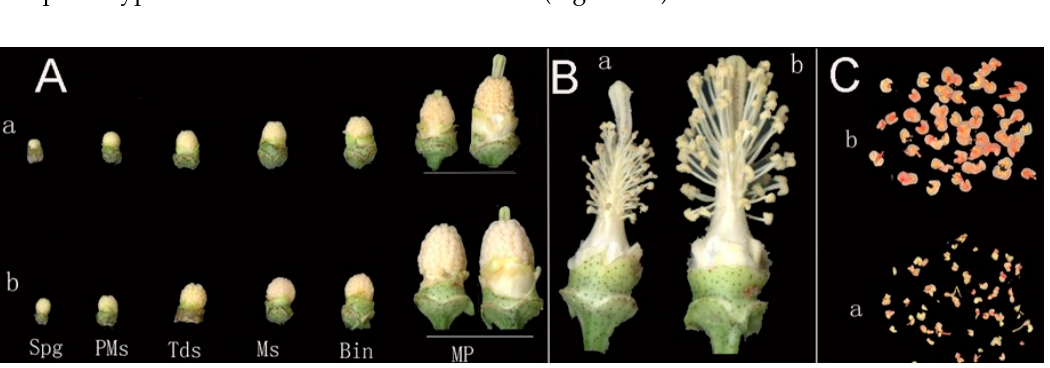
Figure 1. The morphological characteristics of flower buds at different development stages. a, cytoplasmic male sterile line C2P5A; b, maintainer line C2P5B. ( A ) Flower buds after removing sepals and petals. ( B ) Flower with sepals and petals removed. ( C ) Determination of pollen grain activity by TTC. Spg, sporogenous stage; Pms, pollen mother cell stage; Tds, tetrad stage; Ms, mononuclear stage; Bin, binucleate stage; Mps, mature pollen grain stage.